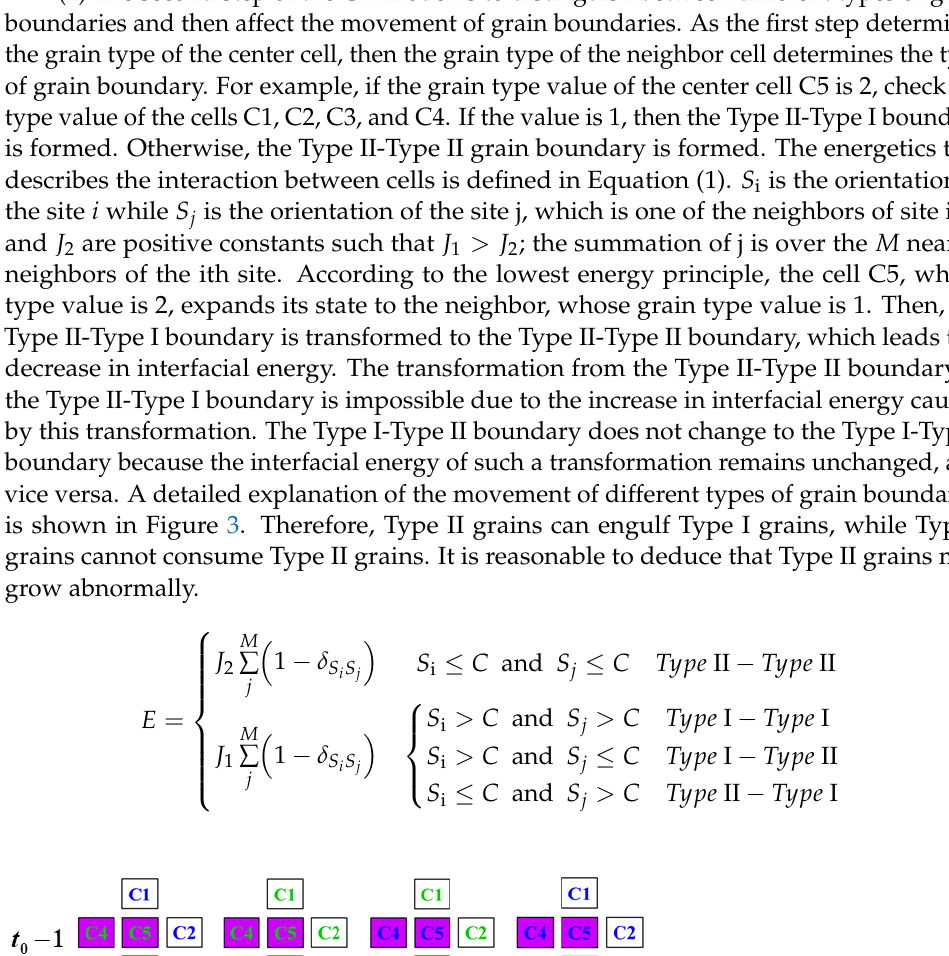
Figure 2. The initial microstructure for AGG.